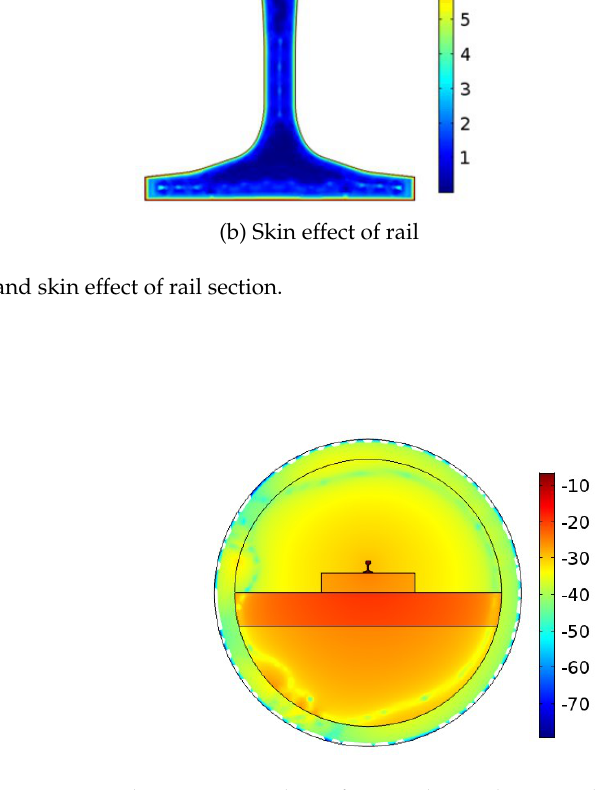
Fig. 7. Electromagnetic loss of external impedance model.